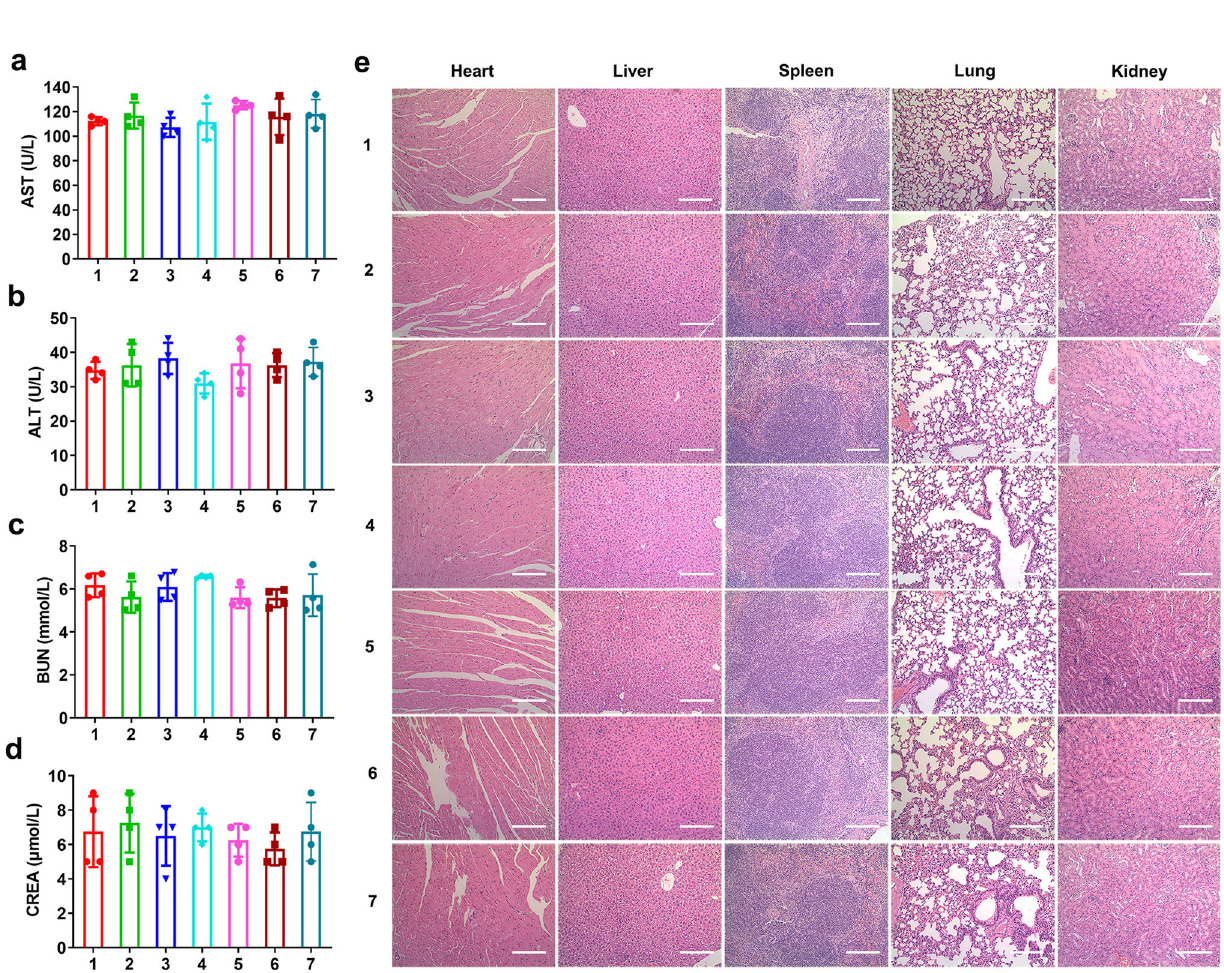
Fig. 9 Therapeutic ef fi cacy and systematic antitumor immune responses mechanism in EMT6-bearing mice. a Schematic illustration of experimental design. Tumor growth curves of b primary tumors (*** p = 0.0001, ** p = 0.0041) and c bone metastatic tumors (*** p = 0.0006, ** p = 0.0062) after various treatments (1: PBS ( + ); 2: free Oxa; 3: Oxa(IV)@ZnPc; 4: Oxa(IV)@ZnPc@M; 5: BMMs + anti-PD-L1; 6: Oxa(IV)@ZnPc ( + ); 7: Oxa(IV)@ZnPc@M ( + ); 8: Oxa (IV)@ZnPc@M ( + ) + anti-PD-L1; 9: Oxa + anti-PD-L1; and 10: Oxa(IV)@ZnPc ( + ) + anti-PD-L1, “ ( + ) ” represent laser irradiation, applied for all the antitumor studies in vivo) ( n = 6 individual animals). d Overall survival curves. e Body weight after various treatments ( n = 6 individual animals). f Schematic illustration of experimental design of antitumor immune evaluation. g Quantitation of the percent of tumor-in fi ltrating CD4 + T cells (*** p = 0.0008, ** p = 0.0095, *** p <0.0001, * p = 0.0467). h The representative fl ow cytometric plots of tumor-in fi ltrating CD4 + T cells and CD8 + T cells ( n = 4 individual animals). Quantitation of the percent of i tumor-in fi ltrating CD8 + T cell (** p = 0.0049, *** p = 0.0004, ** p = 0.0044), j intratumoral ratio of CD8 + T cells to Treg (** p = 0.0014, ** p = 0.0018, * p = 0.0219), k IFN- γ within CD8 + T cells (** p = 0.0043, *** p <0.0001, *** p <0.0001) and l TNF- α within CD8 + T cells (** p = 0.0031, *** p = 0 . 0010, * p = 0.0177) ( n = 4 individual animals). All data were presented as mean±SD. Statistical signi fi cance was calculated via the unpaired two-tailed t test b, ordinary one-